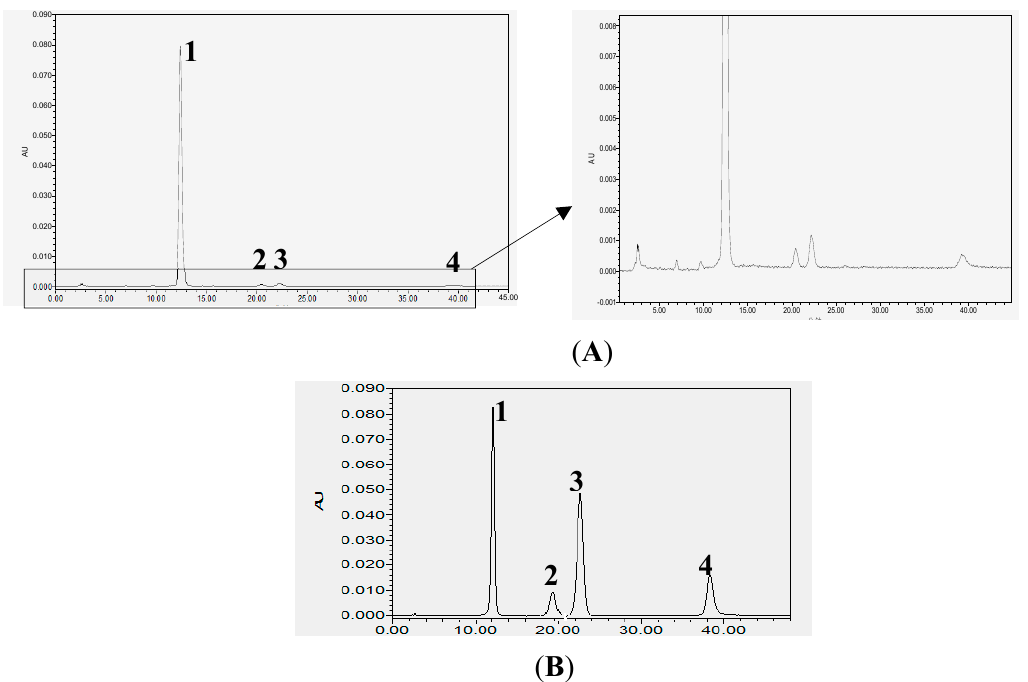
Figure 1. Representative HPLC chromatogram acquired at 270 nm of flavonoids from POE ( A ) and flavonoid standards ( B) . Peaks were tentatively identified as ( 1 ) rutin, ( 2 ) hesperidin, ( 3 ) myricetin, ( 4 ) quercetin.